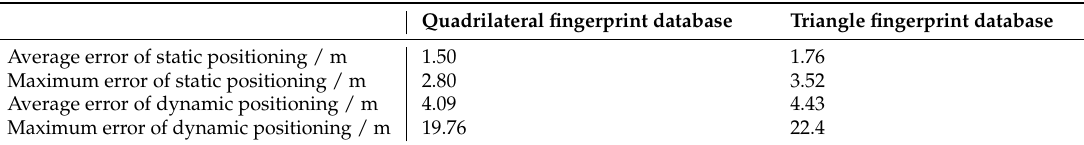
Table 2. Positioning results based on different layout fingerprint